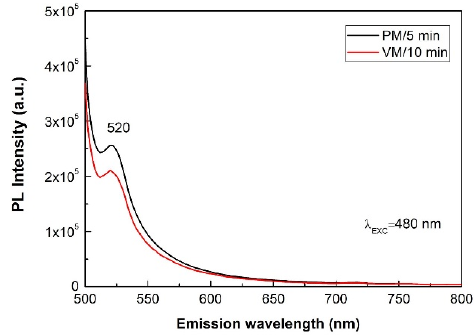
Figure 10. PL spectra of CuSe products after 5 and 10 min of mechanochemical synthesis in planetary (PM) and vibratory (VM) mills at an excitation wavelength of 480 nm.